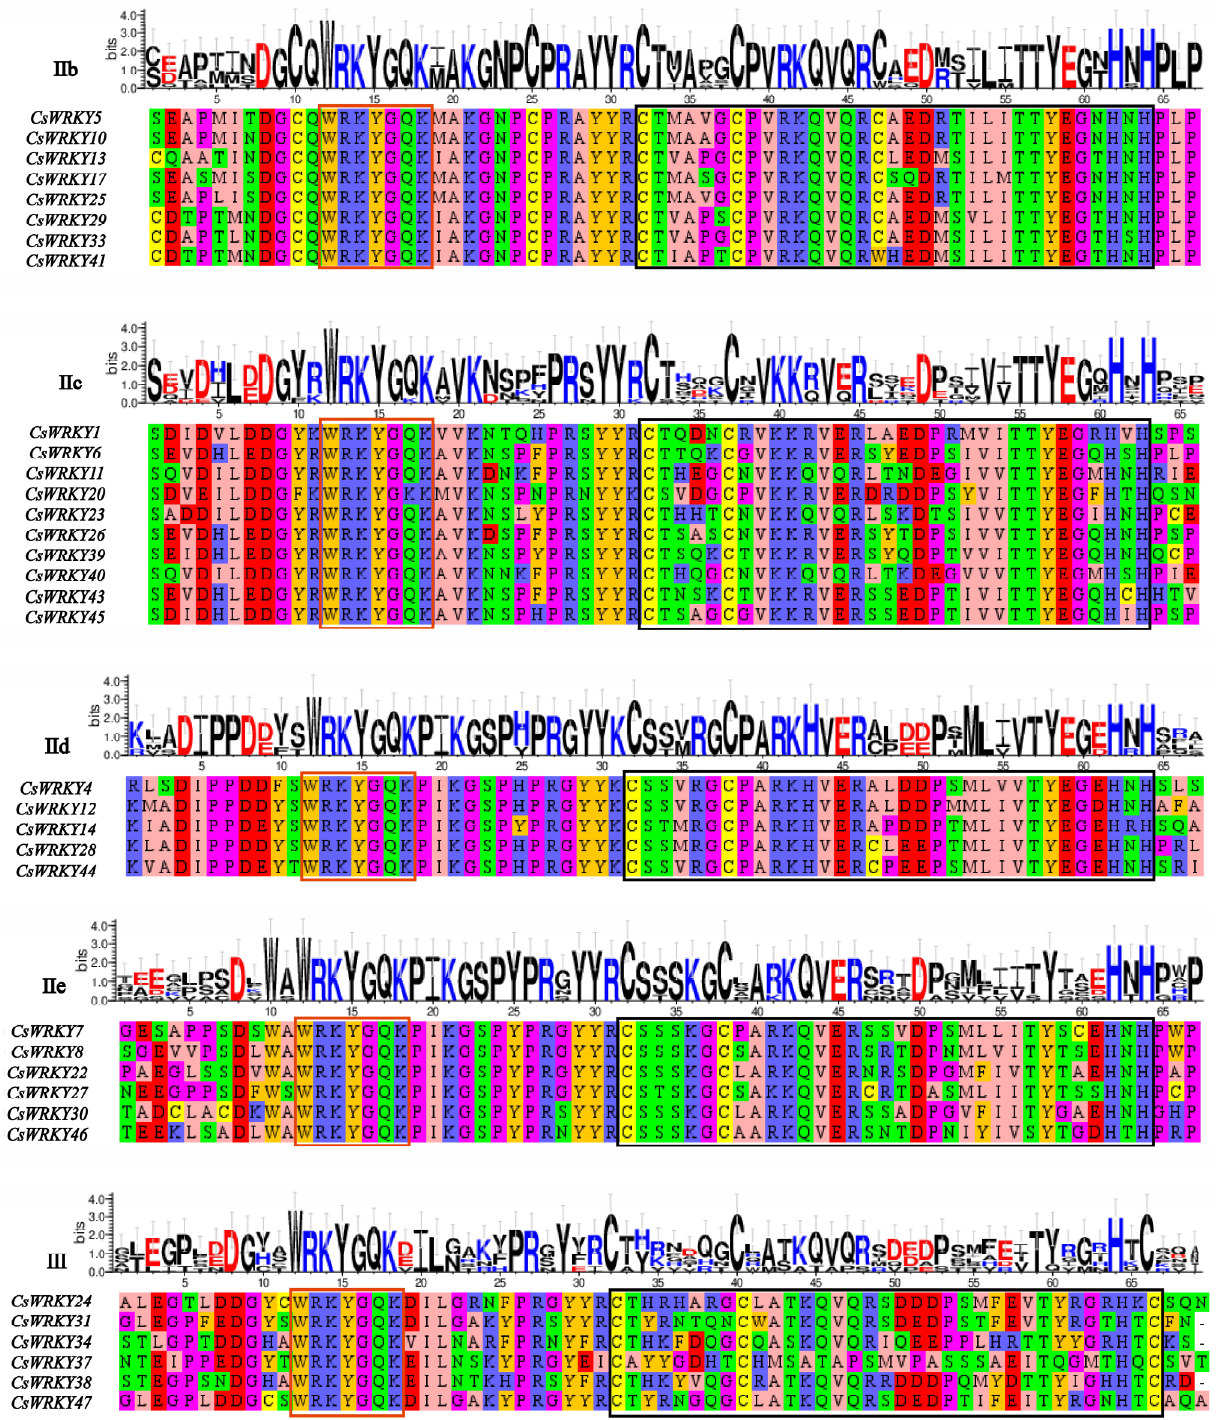
Figure 2. Results of multiple sequence alignment of domains of CsWRKY TFs. Heptad domains were displayed in the red box, while C2H2 or C2HC-type zinc finger structures were displayed in the black box. Roman numerals I, II, and III represented different groups. IN represented the N-terminal WRKY domain of group I, and IC represented the C-terminal WRKY domain of group I. IIa,b,c,d,e were different subgroups. The sequence logos were performed using the online mapping tool WebLogo. The Y -axis (in bits) indicates the overall height of the stack. The type of amino acids occurring at each position reflected the preference of the sequence at that position. The size of each letter was positively correlated with the frequency of amino acids at that position.